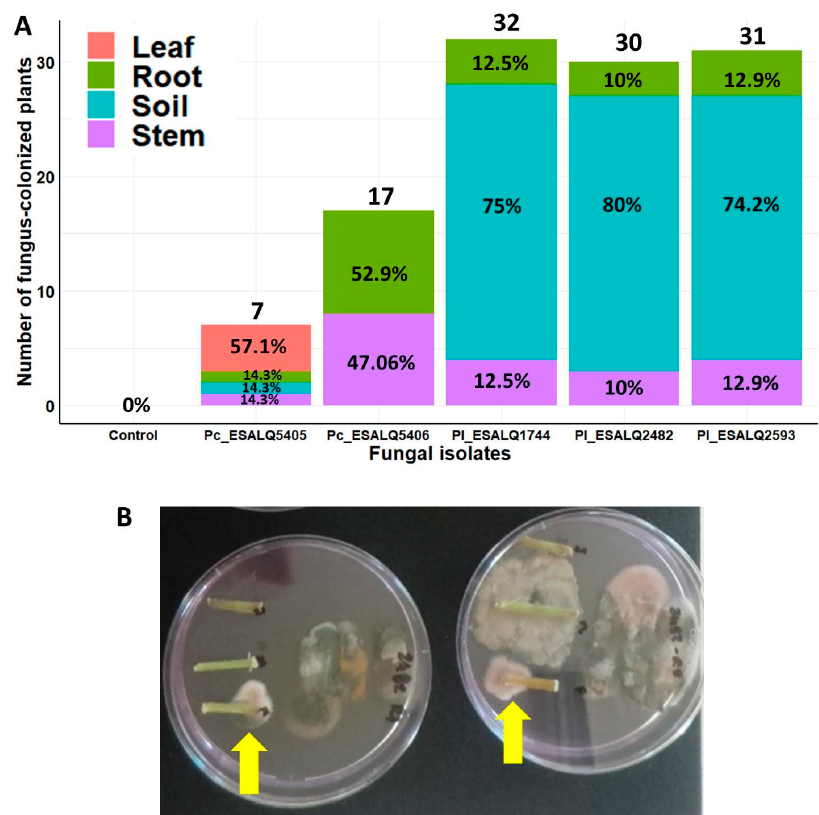
Figure 4. Spatial distribution and frequency of endophytic colonization after seed treatment with Purpureocillium lilacinum (Pl) and Pochonia chlamydosporia (Pc) within different plant tissues from potted bean plants and from the potting soil after 45 days of fungal inoculation and seeding under greenhouse conditions ( A ). Selective medium showing bean stem fragments endophytically colonized by P. lilacinum (indicated by yellow arrows) in ( B ). The total number of plants evaluated per treatment: n = 3 experiments × 4 structures × 10 repetitions = 120 plants. 3.5. Effects of Nematophagous Fungi on Population Growth of T. urticae The effect of fungal isolates through seed coating in grown common bean plants exposed to two-spotted spider mites was measured by the production of eggs per leaf. As shown in Figure 5, the indirect acaricidal effect exerted by all P. chlamydosporia and P. lilacinum isolates was significant, as these fungi induced a striking reduction in the egg numbers laid by spider mite females ( χ 2 = 257.97, df = 5, 113, p < 0.0001). No differences were observed among these fungal isolates, which implies that they were similarly effective in suppressing T. urticae offspring (Figure 5).